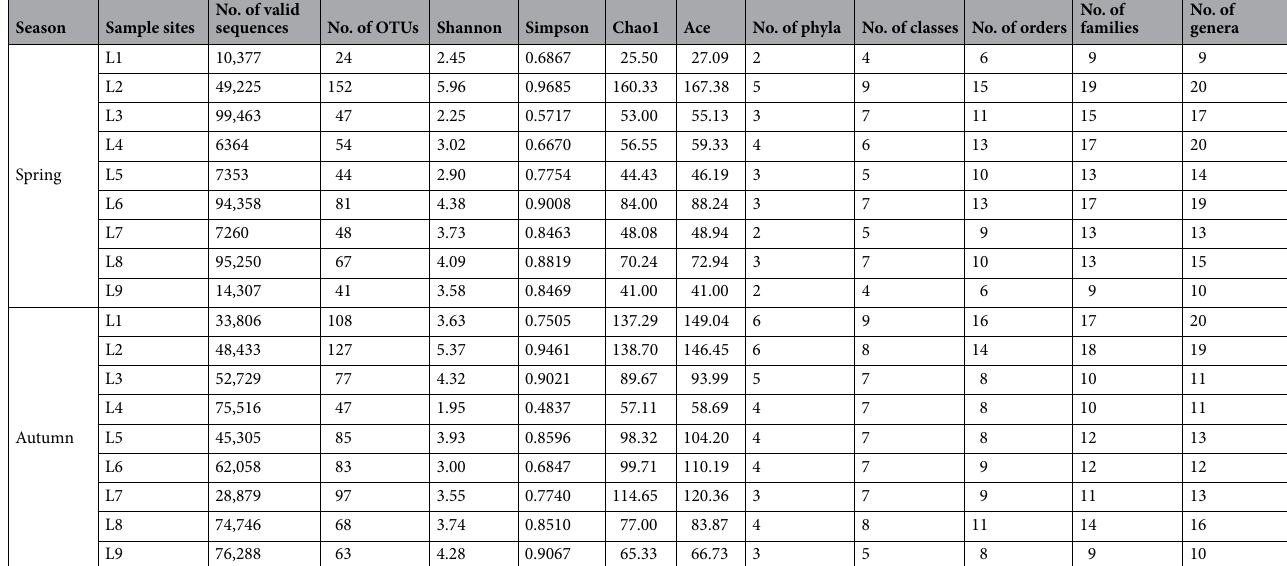
Table 2. The richness and diversity of phoD genes in sediments of the Sancha